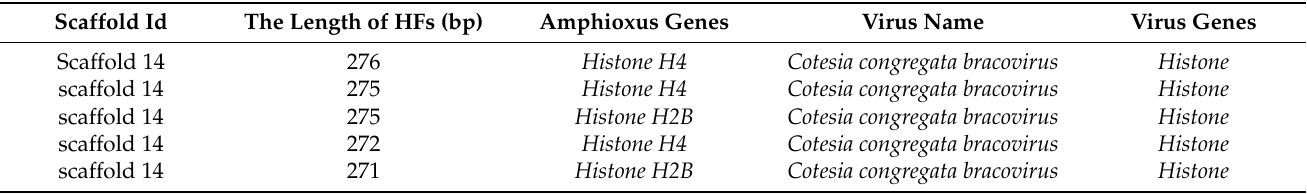
Table 3. The 5 HFs with highest confidence of longest length and the highest alignment